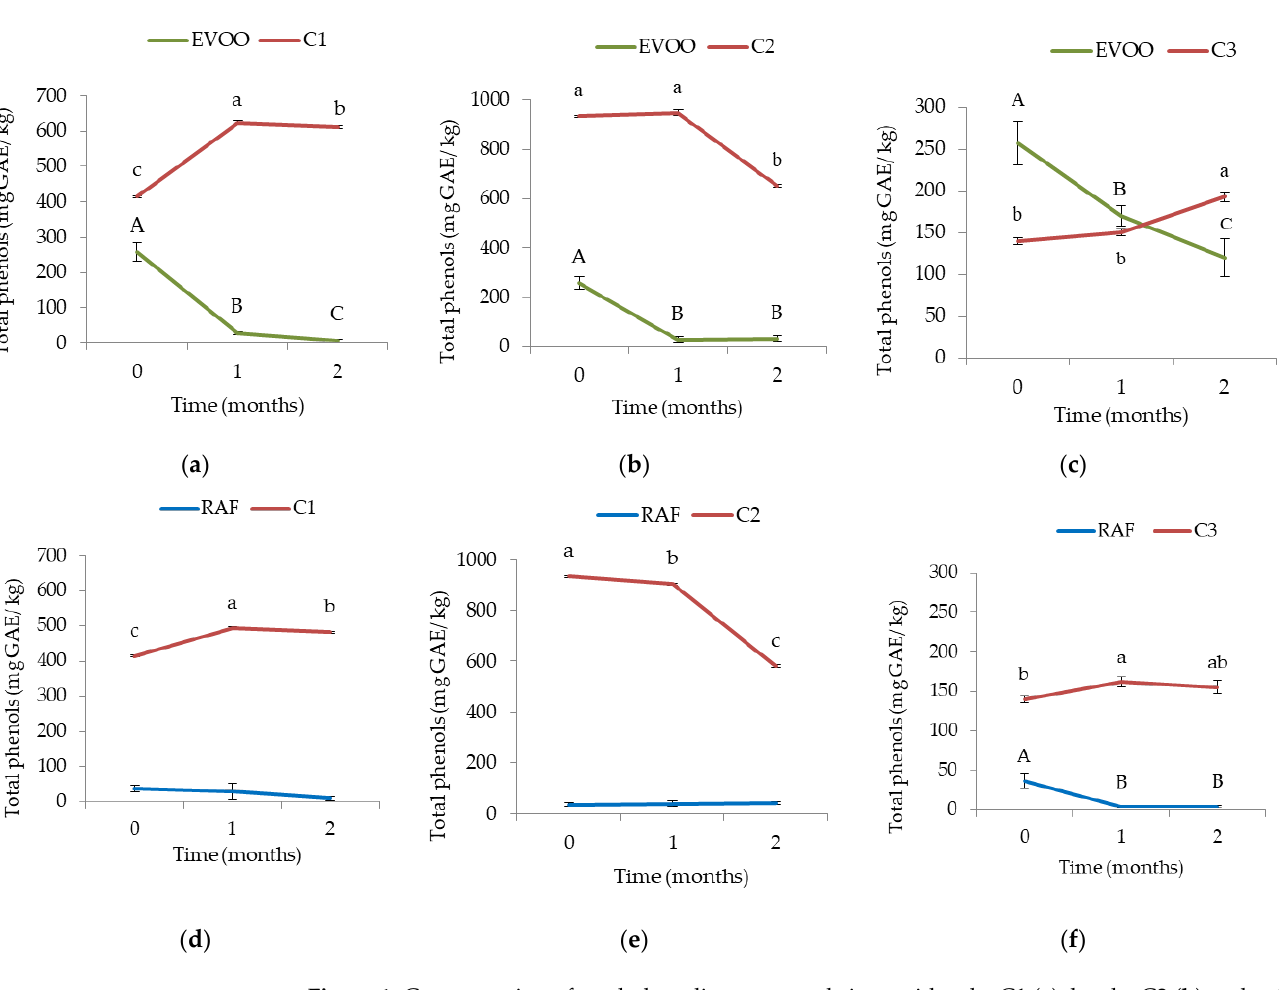
Figure 1. Concentration of total phenolic compounds in semi-hard — C1 ( a ), hard — C2 ( b ) and soft whey — C3 ( c ) cheese immersed in extra virgin olive oil (EVOO) or semi-hard — C1 ( d ), hard — C2 ( e ) and soft whey — C3 ( f ) cheese immersed in refined olive oil (RAF) and concentration of total phenolic content development during two months (month 0, 1, and 2) in the corresponding oil. Results represent the mean values ± standard deviation of three repetitions. Different letters above bars represent significant differences among single cheese (different small letters) or oil (different capital letters) at different storage time (0, 1, and 2) (Tukey´s test, p < 0.05).